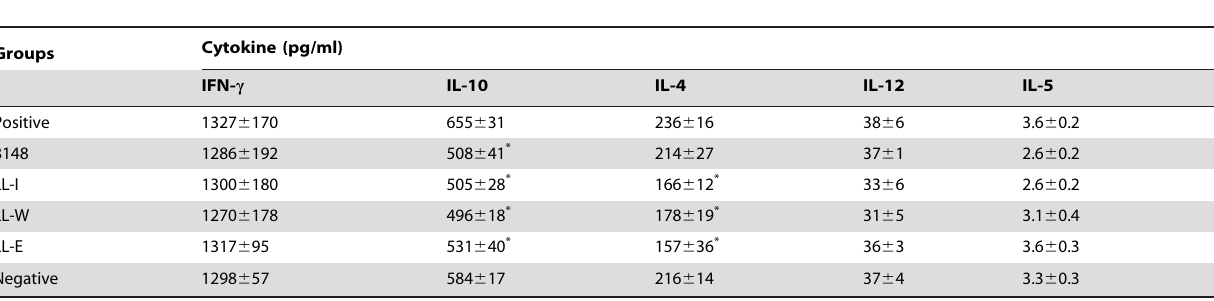
Table 3. Cytokine production in the MLN cell culture supernatants in vitro .